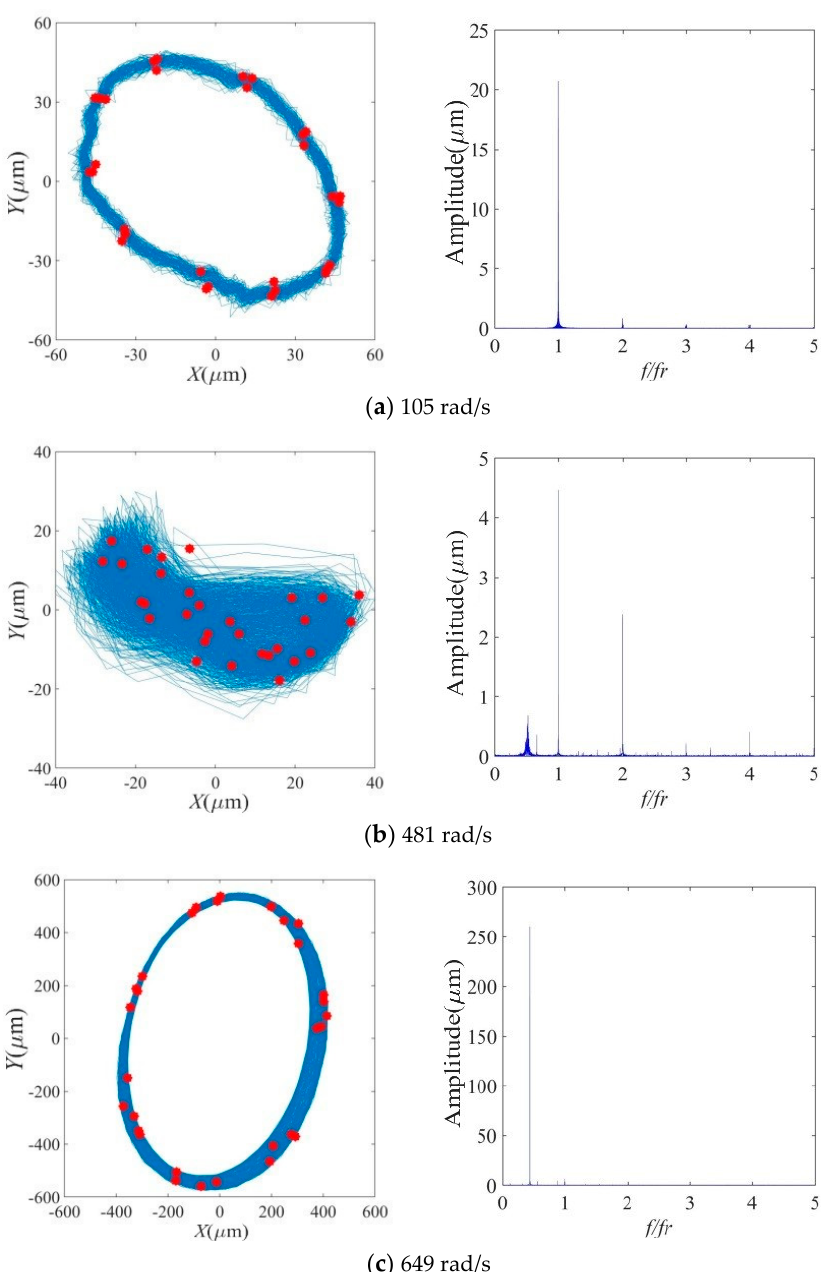
Figure 12. Trajectory of shaft center with the Poincaré map ( left side ) and the power spectrum ( right side ) for the rotating disk at different rotating speeds.